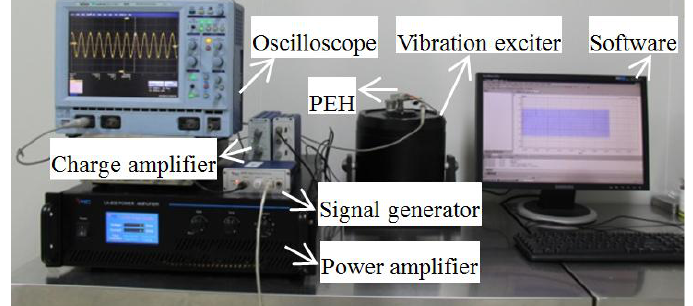
Figure 11. Photo of the experimental setup for MEMS piezoelectric energy